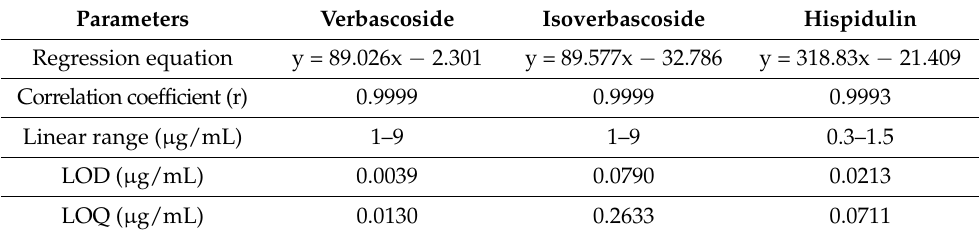
Table 2. Method validation parameters by the proposed HPLC method.